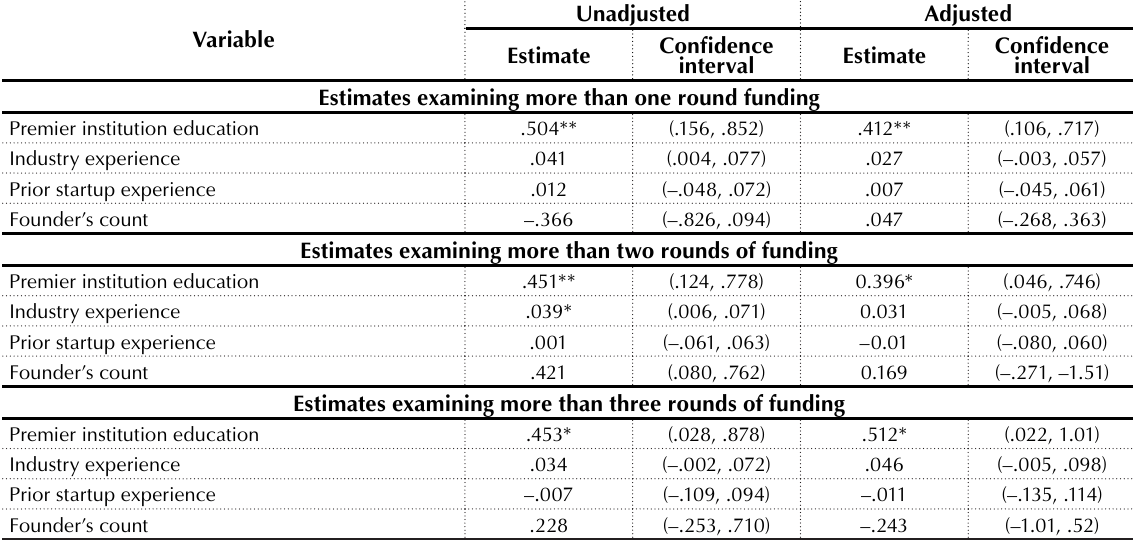
Table 3. Estimates for raising funds across multiple rounds of funding using binary logit regression